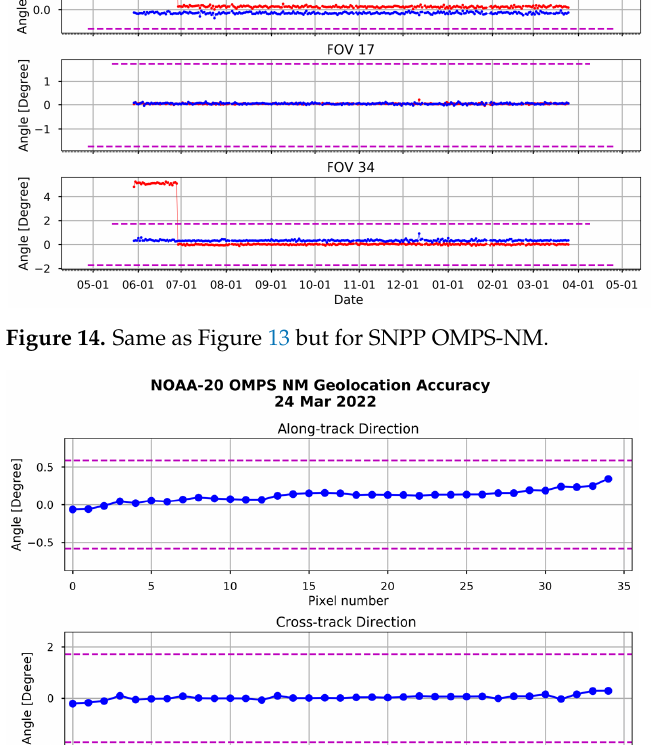
Figure 15. Same as Figure 11 but on 24 March 2022 after the view angle table was updated.